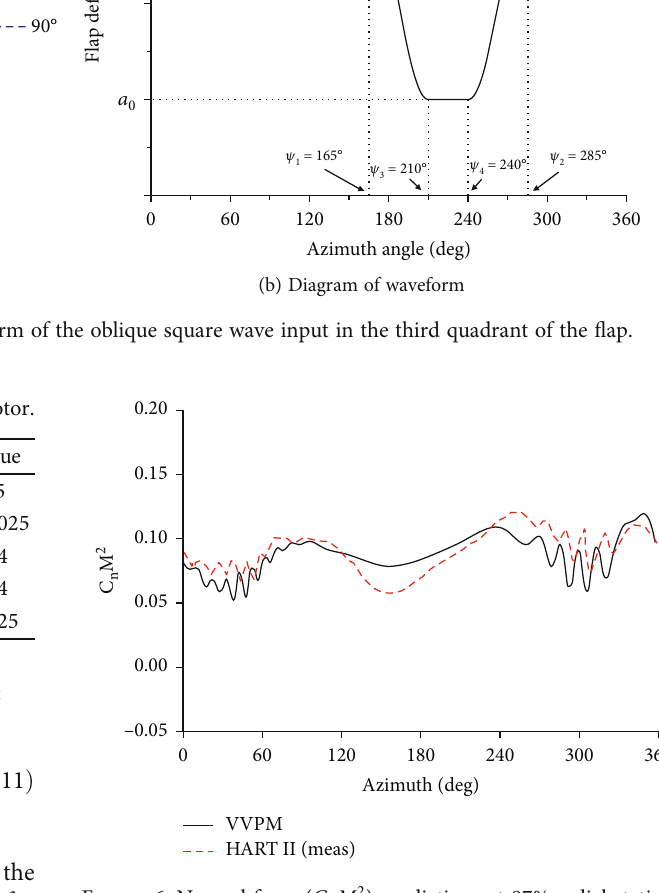
Figure 6: Normal force ( C